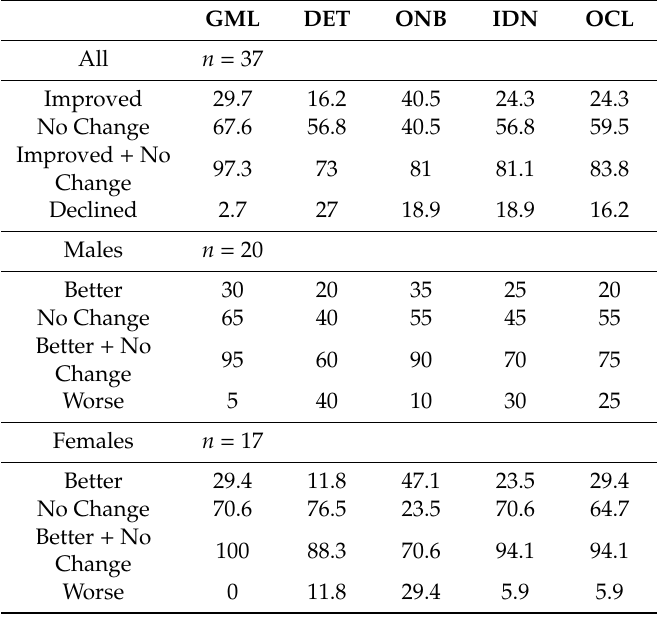
Table 11. Reliable Change Index: Percentages of participants with clinically relevant changes in cognition according to the Reliable Change Index